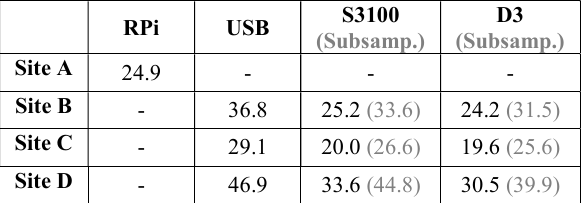
Table 3. Estimated precision of image blocks (in mm) based on Eq. 1.